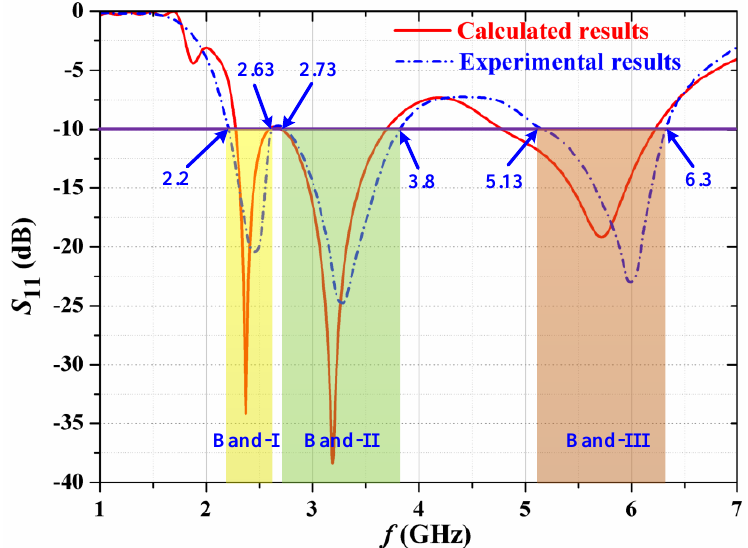
Figure 13. Calculated and experimental S11 of the proposed NTTPA.